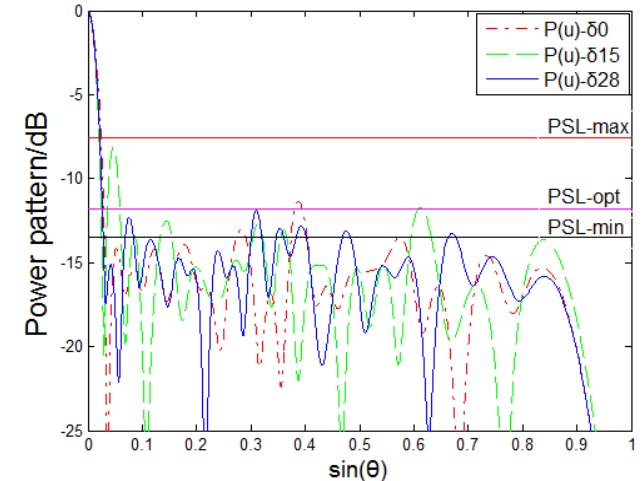
= , 0 φ= , and 0 ϕ= ; σ = 0, 15, and 28, respectively. Figure 6. Power pattern when K = 20, φ = 0, and ϕ = 0; σ = 0, 15, and 28,